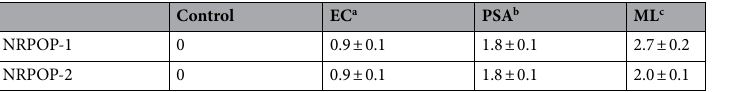
Table 3. Diameters (cm) of inhibition rings of the bacteria on a petri dish by the loaded polymers. a Escherichia coli (MicroKwik Culture # 155065A). b Pseudomonas aeruginosa (MicroKwik Culture # 155250A). c Micrococcus luteus (MicroKwik Culture #